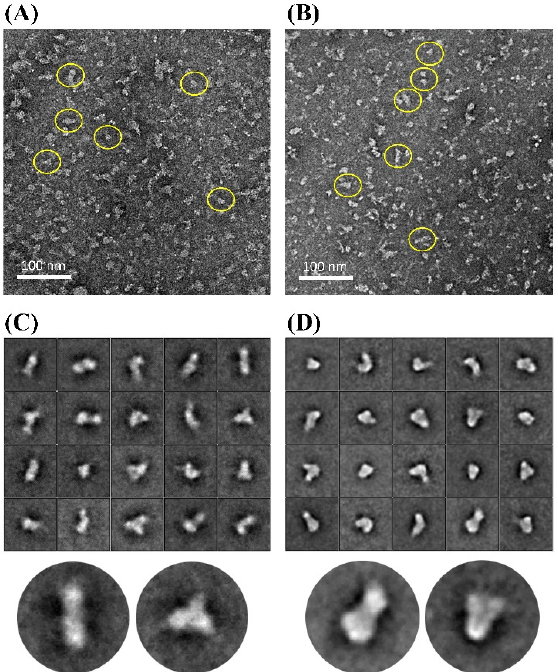
Figure 4. Negative staining transmission electron microscopic analysis of HA ectofusion immunogens ( A ) Negative staining raw micrograph of mMH3H1F_02TE ectofusion showing elongated conjugates. ( B ) Negative staining raw micrograph of mMH3FH1F_02TE ectofusion showing elongated conjugates. Particles have been marked within the yellow boundary. ( C ) Reference-free 2D class averages of mMH3H1F_02TE ectofusion showing the various orientations of the immunogens. Lower panel denotes magnified view of two representative classes of the molecule. ( D ) Reference-free 2D class averages of mMH3FH1F_02TE ectofusion showing the various orientations of the immunogens. Lower panel denotes magnified view of two representative classes of the molecule.